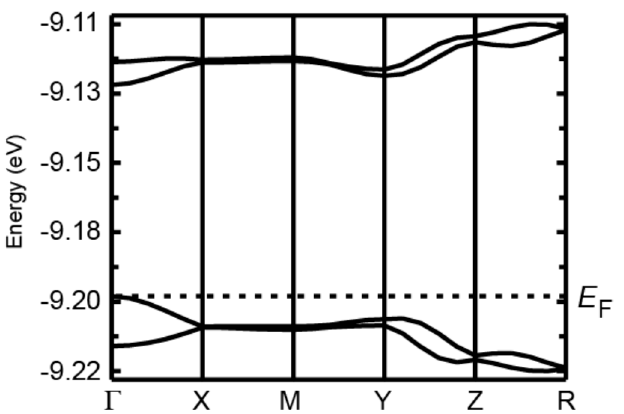
Figure 3. Calculated band structure of 2 using a tight-binding approximation. The broken line ( E F ) designates the Fermi level. Г , X, M, Y, Z and R designate points in reciprocal space located at (0,0,0), (0.5,0,0), (0.5,0.5,0), (0,0.5,0), (0,0,0.5) and (0.5,0.5,0.5), respectively. Band structures of other salts and those of wider energy ranges are shown in Figure S1 in the Supplementary